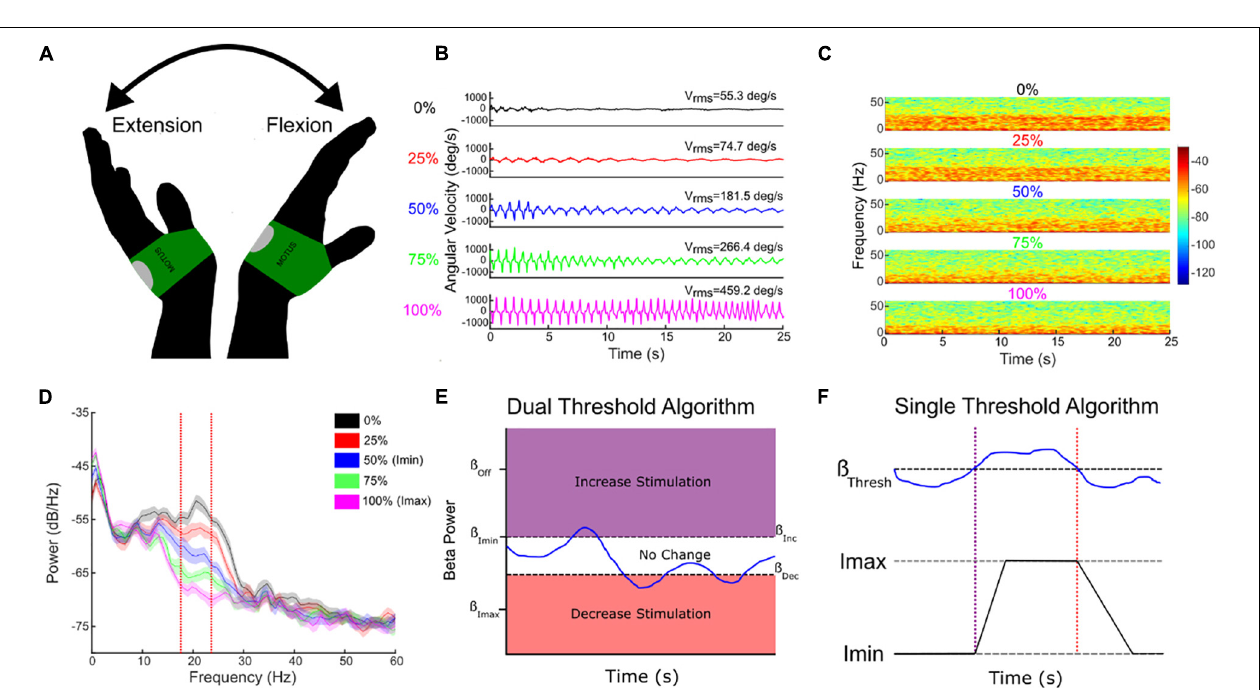
FIGURE 5 | Individual randomized presentations of STN DBS intensity, normalized to the maximum tolerated without side effects (Imax, 100%, pink traces), during a repetitive wrist flexion extension task (A,B) , determine the safe and acceptable range (Imin (here 50% Imax) to Imax), through which DBS intensity will fluctuate (B–E) . Corresponding beta power measured at Imin and Imax determine the upper and lower beta thresholds for the dual threshold algorithm (D,E) , and the beta power for the single threshold algorithm (F) . Blue line (E,F) —fluctuating beta